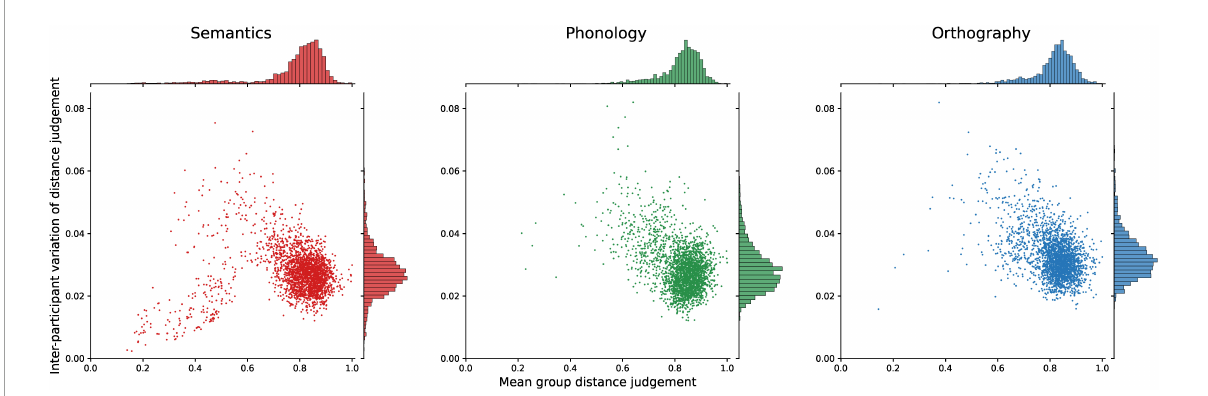
FIGURE6 Variance in similarity judgments between participants for word pairs as a function of the word pairs’ average group dissimilarity. On the y-axis is the participants’ agreement on a word pair, with 0 indicating perfect agreement and 1 total disagreement. On the x-axis, the average dissimilarity judgment is given for each pair at the group level, with 0 indicating perfect similarity, and 1 total dissimilarity.